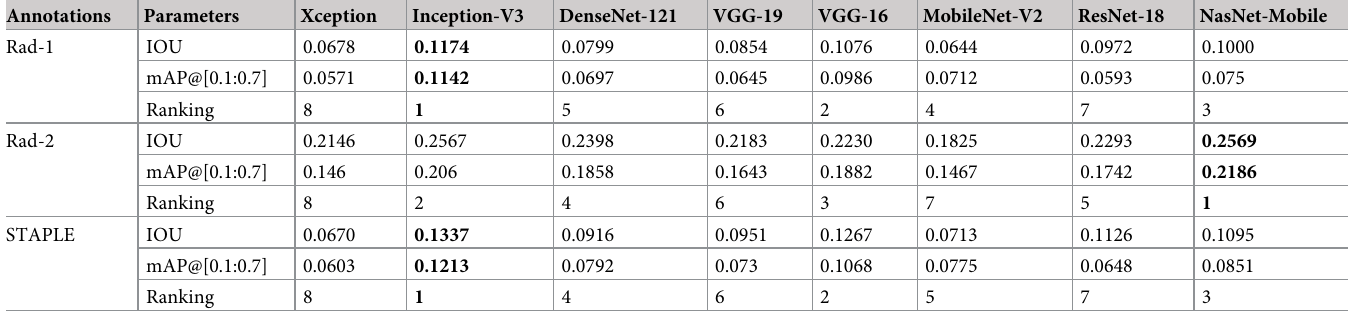
Table 8. Performance achieved in terms of CRM-based IoU and mAP values by the individual fine-tuned CNNs using the radiologists’ annotations and STAPLE- generated ROI consensus annotation.